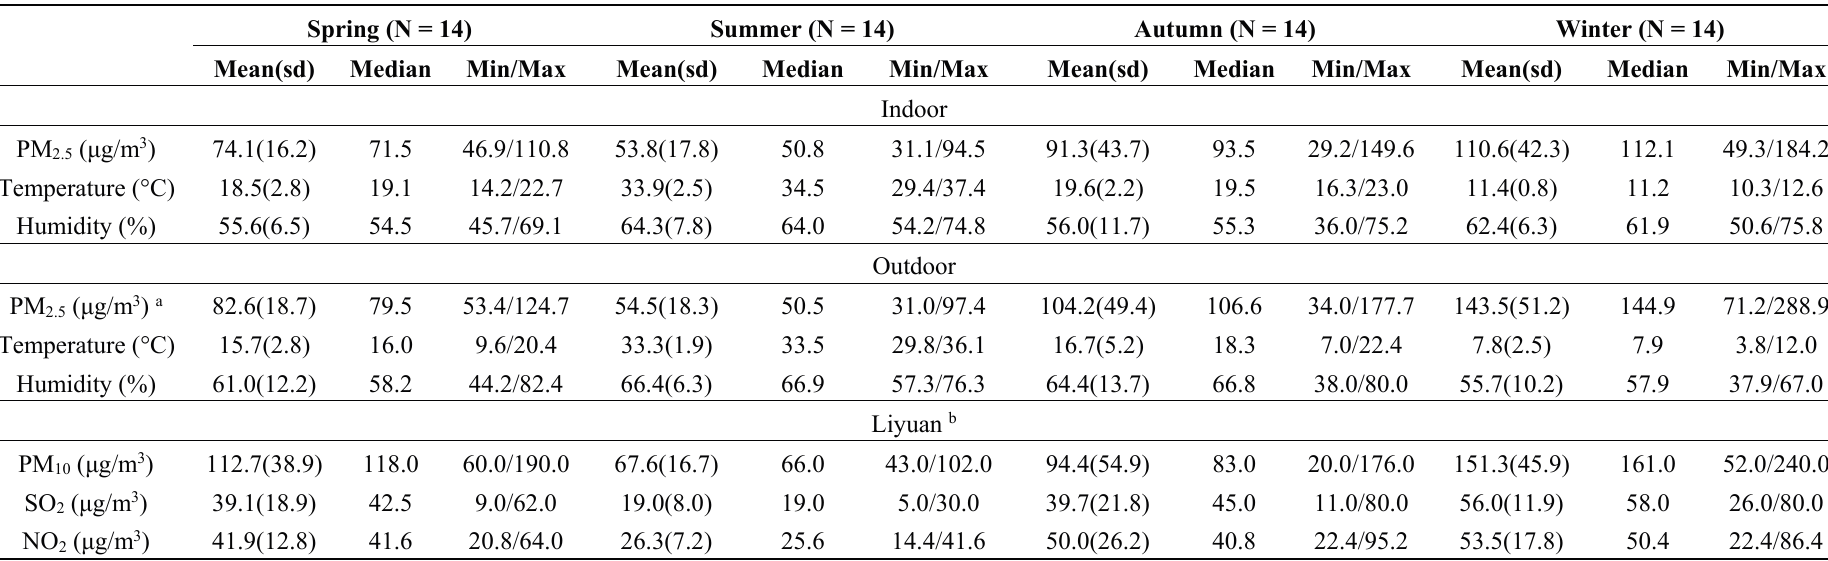
Table 2. Descriptive statistics for the meteorological conditions and air